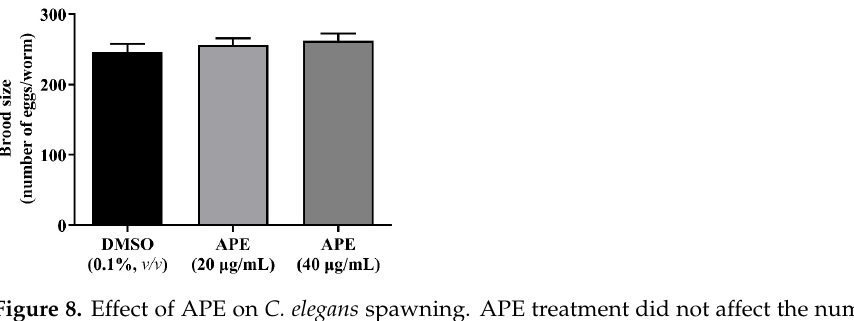
Figure 7. Effect of APE on age-related decline in pharyngeal pumping. It was observed that 40 µg/mL APE significantly attenuated the pharyngeal pumping rate in the C. elegans aging process. Statistical significance was analyzed by one-way ANOVA, Dunnett test. * p < 0.05 versus the DMSO of each time point.